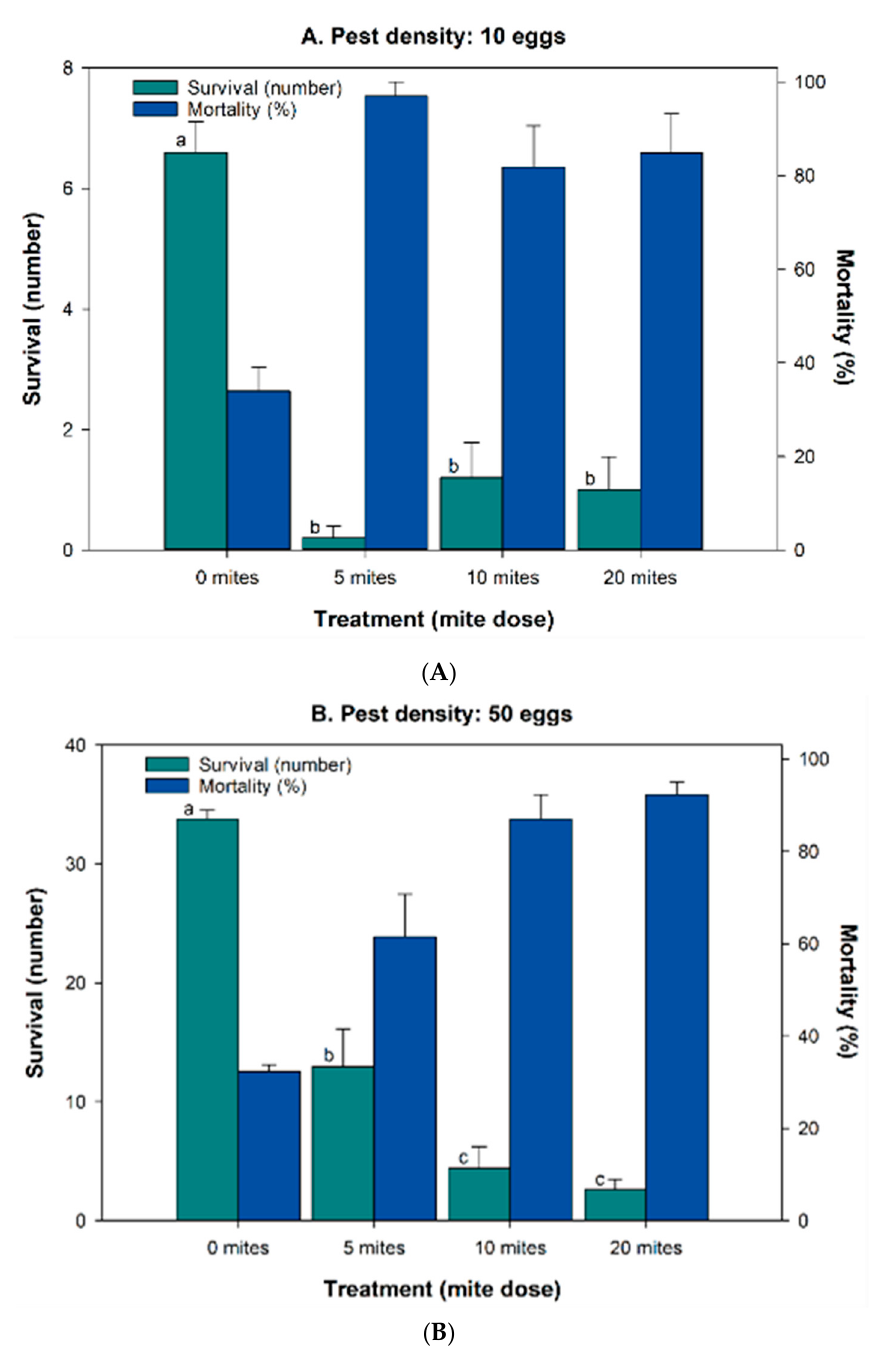
Figure 1. Number of survivors (±SE) and percentage of mortality (±SE) in Phthorimaea operculella , at 28 days, in two bioassays carried out under microcosm conditions (with potato tubers and 25 ± 1 °C, and 16:8 h L:D), when the initial infestation by the pest was 10 ( A ) or 50 ( B ) Phthorimaea operculella eggs/container, respectively, and three release rates of the predatory mite Blattisocius tarsalis were used (0, 5, 10 and 20 adult mites/container). (In each figure, values with different letters indicate significant differences at P = 0.05).